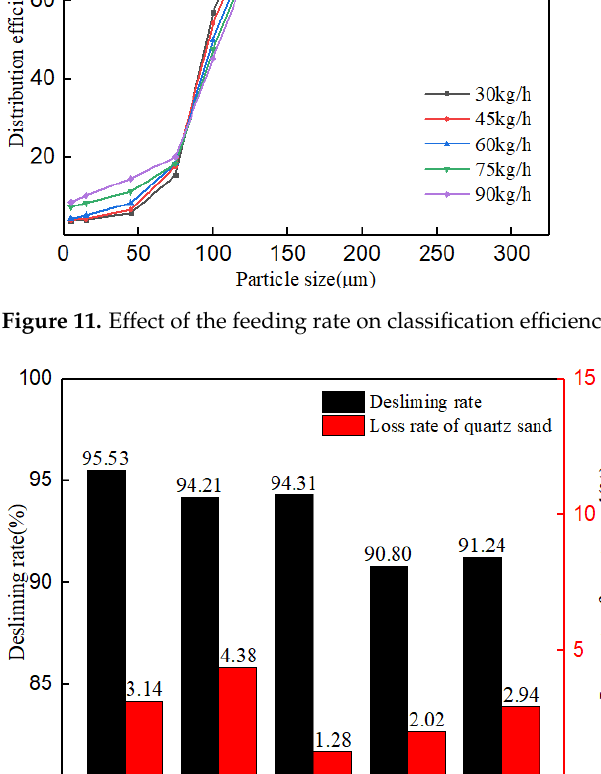
Figure 12. Effect of the feeding rate on the desliming performance. As shown in Figure 12, with the increase in the feeding rate, the desliming rate of the hydrocyclone sand washer decreased gradually. As the feeding rate increased from 30 kg/h to 60 kg/h, the desliming rate decreased slightly by 1.22% from 95.53% to 94.31%; as the feeding rate further increased to 75 kg/h and 90 kg/h, the desliming rate dropped significantly by 3.51% to 90.80%, and the loss rate of quartz sand varied slightly. At a feeding rate of 45 kg/h, the loss rate of quartz sand was highest and reached up to 4.38%; at a feeding rate of 60 kg/h, the loss rate of quartz sand dropped to the minimum, 1.28%. The loss rate of quartz sand first decreased and then increased with the increasing feeding rate. The separation process in the hydrocyclone sand washer includes not only the cen- trifugal sedimentation of solid particles under the action of water; it also includes the interference of interaction among particles. As the feeding rate increased, the concentration in material separation increased, more solid particles were processed in the hydrocyclone sand washer, both the density and viscosity of fluid increased, and the interference